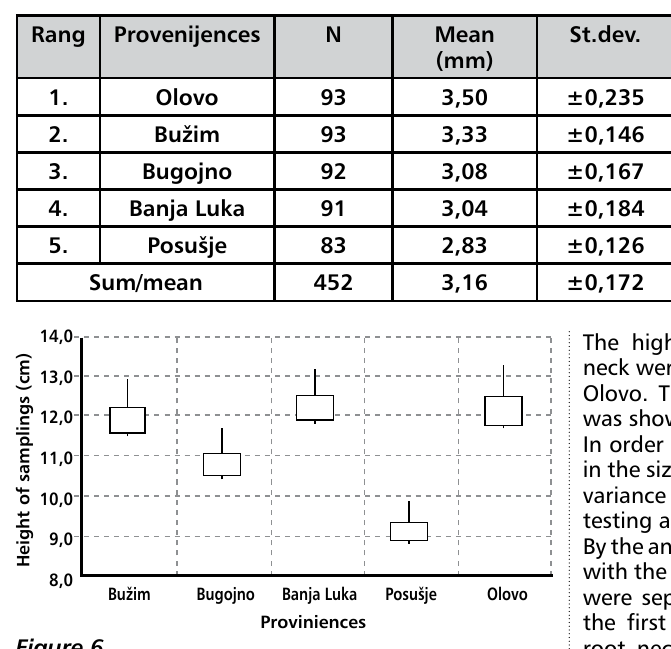
Coefficient of the shape of seeds (Cl/w) per Diameter at the root neck (mm) per proveniences Mean values of the coefficient of seeds Cl/w, per proveniences (St. dev. = standard deviation, CV= coefficient of variability)